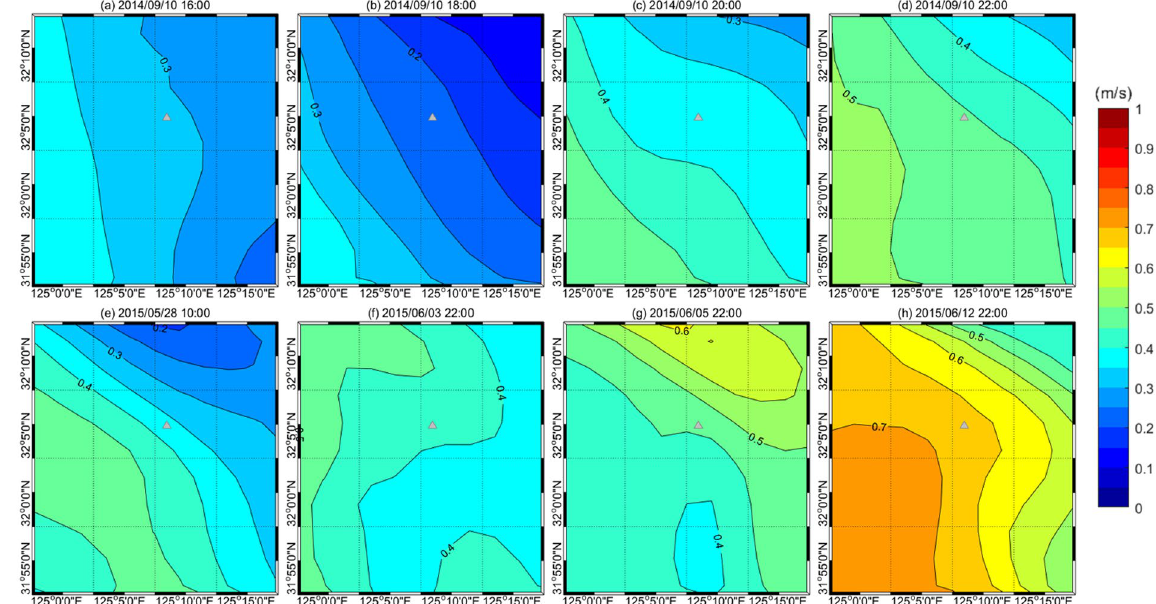
Figure 4. Horizontal map of apparent free wave speed in the vicinity of the IORS. Apparent free wave speed in m s − 1 ( c , color bar in the right) incorporating an effective Doppler shift due to the advective flow (speed: U ) at the surface ( c 1 ) for cases of ( a ) 16:00, ( b ) 18:00, ( c ) 20:00, and ( d ) 22:00 in September 10, 2014, ( e ) 10:00 May 28, ( f ) 22:00 June 3, ( g ) 22:00 June 5, and ( h ) 22:00 June 12, 2015. The sill location is denoted by grey triangle in each